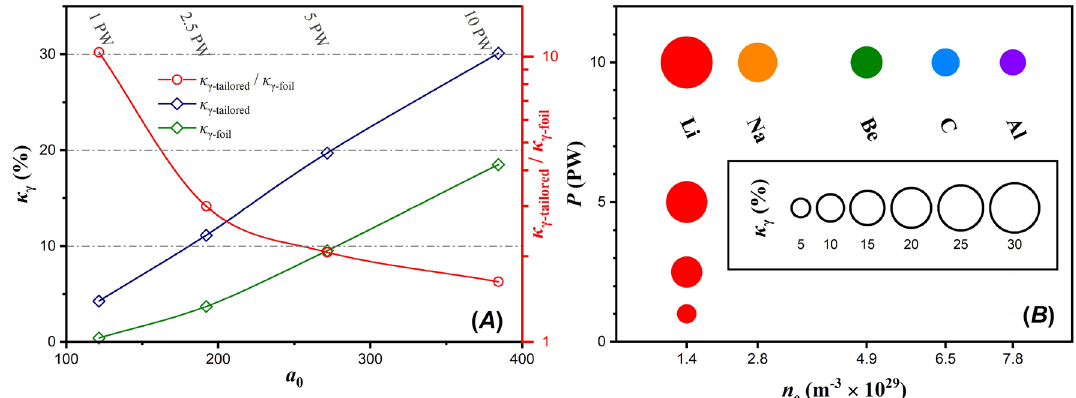
Figure 5. ( A ) The left axis shows κ γ as a function of a 0 , for tailored (blue) and foil (green) lithium targets. The right axis shows the ratio of the two aforementioned cases. ( B ) κ γ as a function of laser power, for various tailored target materials. The κ γ value is proportional to the circle